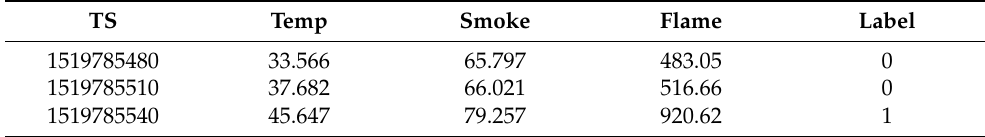
Table 2. A sample of the fire outbreak